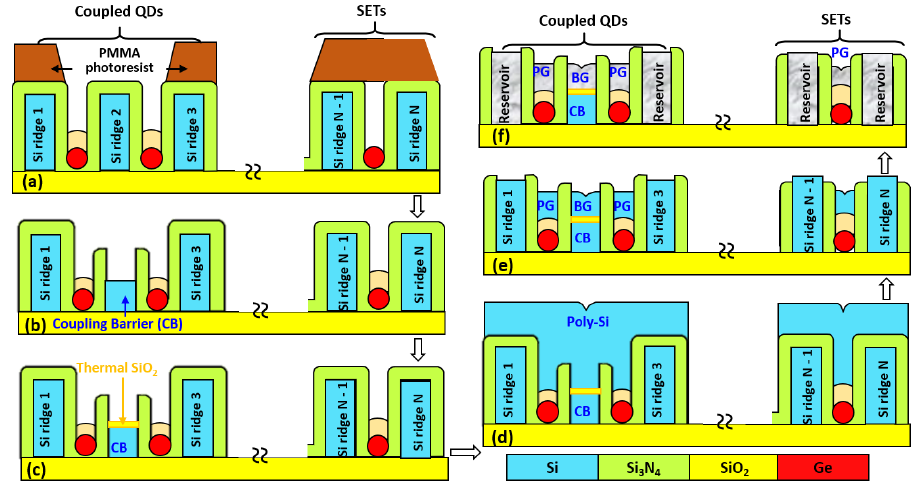
Figure 1. Process flow diagrams showing the fabrication of multiple QDs embedded within SiO 2 /Si 3 N 4 matrices via the thermal oxidation of SiGe spacer islands at designated included-angle locations of Si 3 N 4 /c-Si ridges. ( a ) Lithographically patterned Si 3 N 4 /c-Si fanout ridges on top of an SOI substrate. ( b ) Next, sequential deposition of Si 3 N 4 and poly-Si 0.85 Ge 0.15 layers conformally encap- sulates the Si 3 N 4 /c-Si ridges. ( c ) Symmetrical spacer stripes of poly-Si 0.85 Ge 0.15 are subsequently fab- ricated at each sidewall of the Si 3 N 4 /c-Si ridges by a direct etch back process. ( d ) Lithographic-pat- terning shadowing the central regions of the designed fanout ridges in combination with ( e ) etching processes are conducted to define the lengths of the poly-Si 0.85 Ge 0.15 spacer islands. ( f ) Next, spherical Ge QDs are formed at each included-angle location of the nano-patterned Si 3 N 4 /c-Si ridges sidewall by thermal oxidation. The inset is the plan-view sketch showing the simultaneous formation of mul- tiple Ge QDs at each included-angle locations of Si 3 N 4 /c-Si ridges by design.